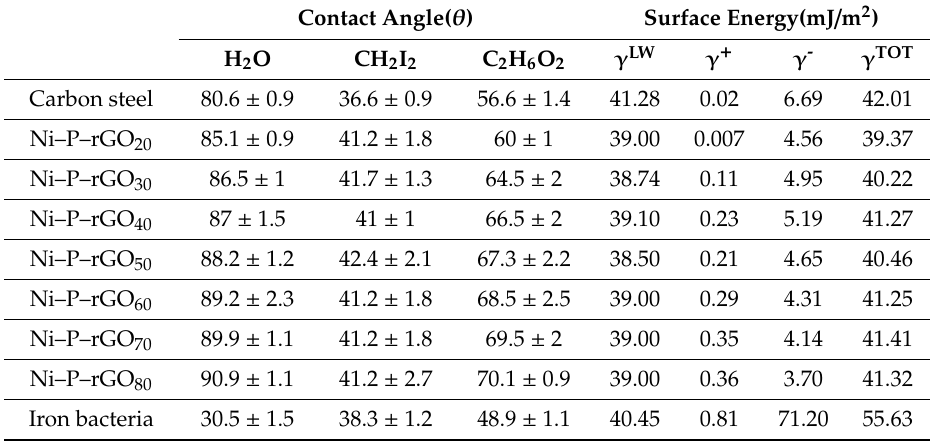
Table 3. The contact angles and surface energies among the three selected liquids and the di ff erent coating